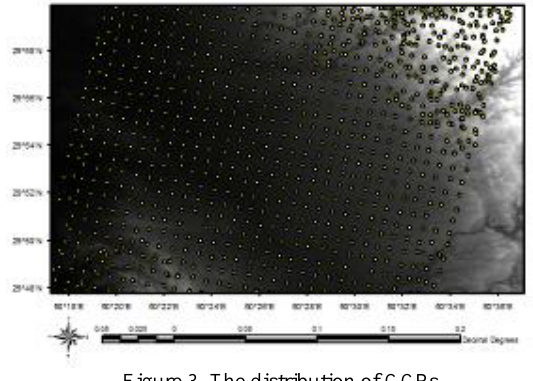
Figure 3. The distribution of GCPs